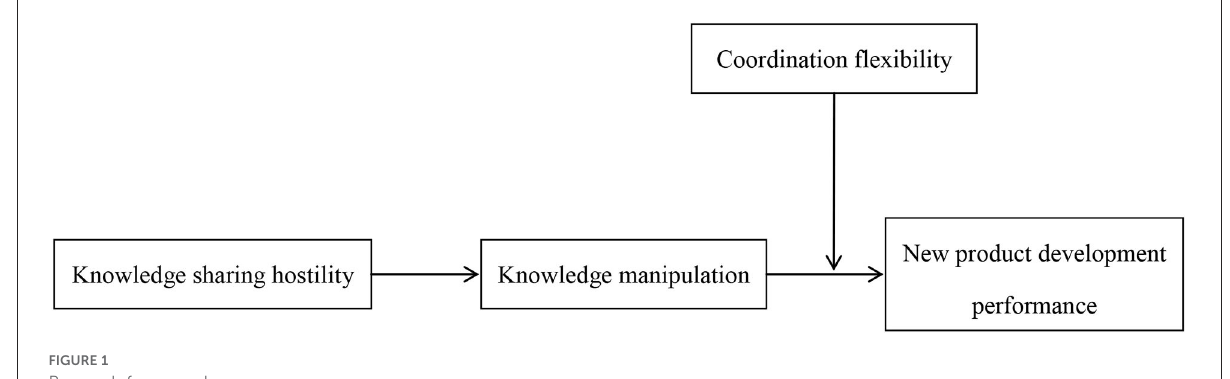
FIGURE1 Research framework.